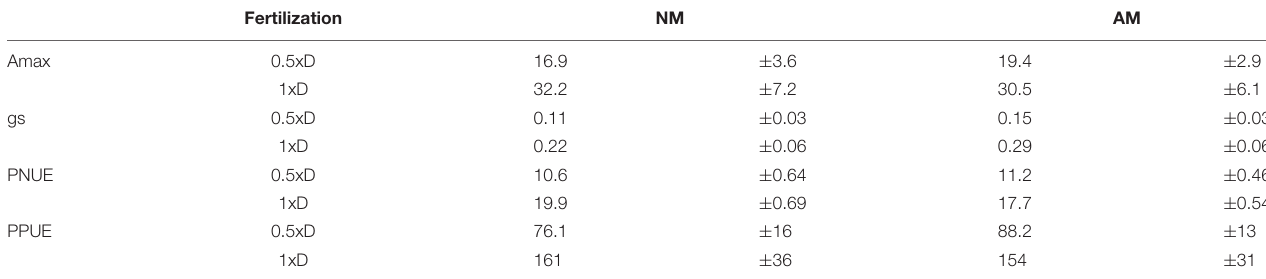
FIGURE 4 | Effect of increasing fertilization on nitrogen status (A) and PSII quantum conversion (B) of the middle leaves, as indicators of nutritional status of NM and AM plants. Rfd, chlorophyll fluorescence decrease ratio; Fv/Fm, maximum quantum yield of PSII in the dark-adapted state. The bars represent average values taken from middle leaves (L4 + 5, ear leaf and leaf above) at the time of tasseling (10 weeks after sowing), after 4 weeks fertilization with one of 4 dilutions of maximal (1xD) dose. The error bars show the standard error of the mean ( n = 80 for NBI, Chl and Flv: 4 plants × 2 leaves × 10 sampling points covering upper half of leaf length, n = 8 for Rfd, Fv/Fm: 4 plants × 2 leaves). Asterisks show statistically significant difference between NM and NM means according to t -Student test ( ∗ p < 0.05, ∗∗ p < 0.01, ∗∗∗ p < 0.001). TABLE 1 | Effect of mycorrizae and fertilization level on light-saturated photosynthetic efficiency of the middle